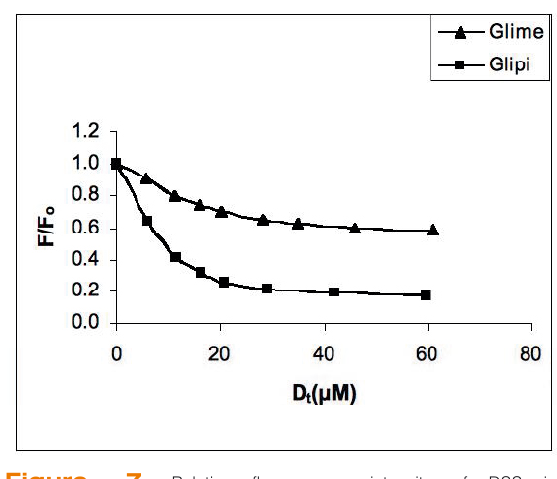
7. Relative fluorescence intensity of DSS in HSA-DSS complex as a function of drug concentration. DSS: Relative fluorescence intensity (F/F ) of DSS in 0 HSA-DSS mixture in the presence of increasing amounts of drugs is shown in Fig. 7 . It is seen that the addition of drugs to HSA-DSS mixture results in a decrease of DSS fluorescence in the case of both the drugs indicating that the drugs displace DSS from its binding site. The percentage displacement (D) was about 41 and 83% at a drug concentration of 60 μM in the case of glimepiride and glipizide, respectively. The maximum displacement, calculated from the intercept of the linear double reciprocal (1/D versus 1/[Drug] ) plots, was found to be nearly 100% in both